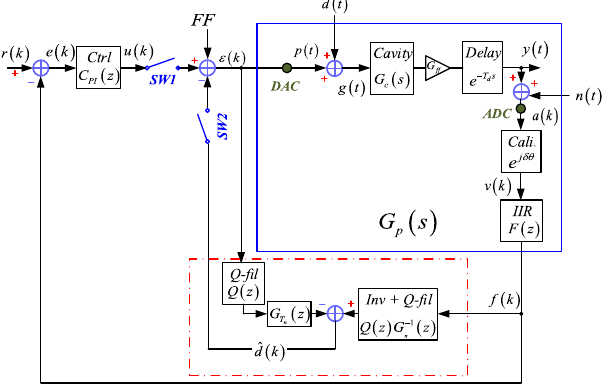
FIG. 4. Overall model of “ PI þ DOB ” control. The presented DOB controller is indicated by the red block. Detailed definitions of each parameter are given in Table II.